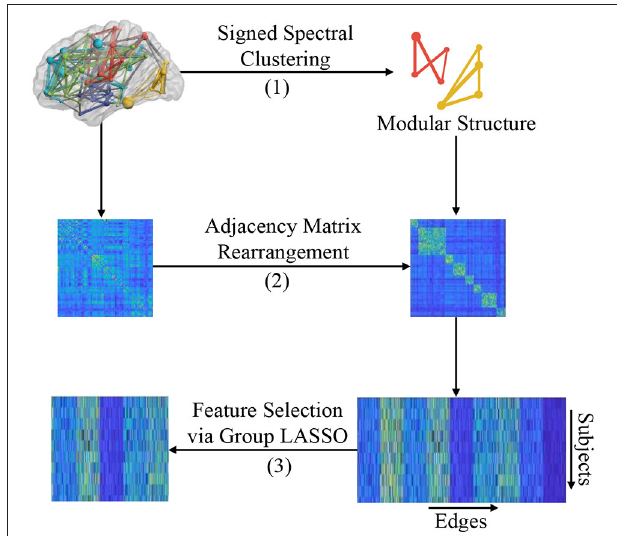
FIGURE 3 | Illustration of the proposed MLFS framework that includes three major parts: (1) modular structure extraction based on signed spectral clustering, (2) adjacency matrix rearrangement based on the extracted modular structure, and (3) feature selection based on group